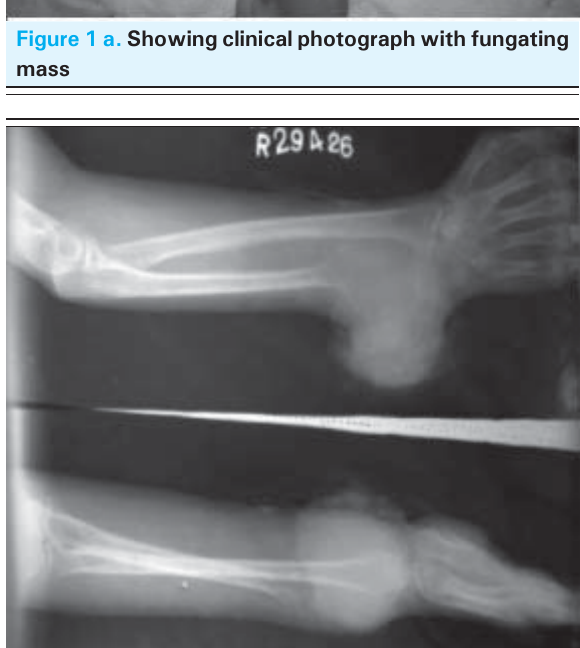
Figure 1 b. Showing complete destruction of distal ulna with soft tissue